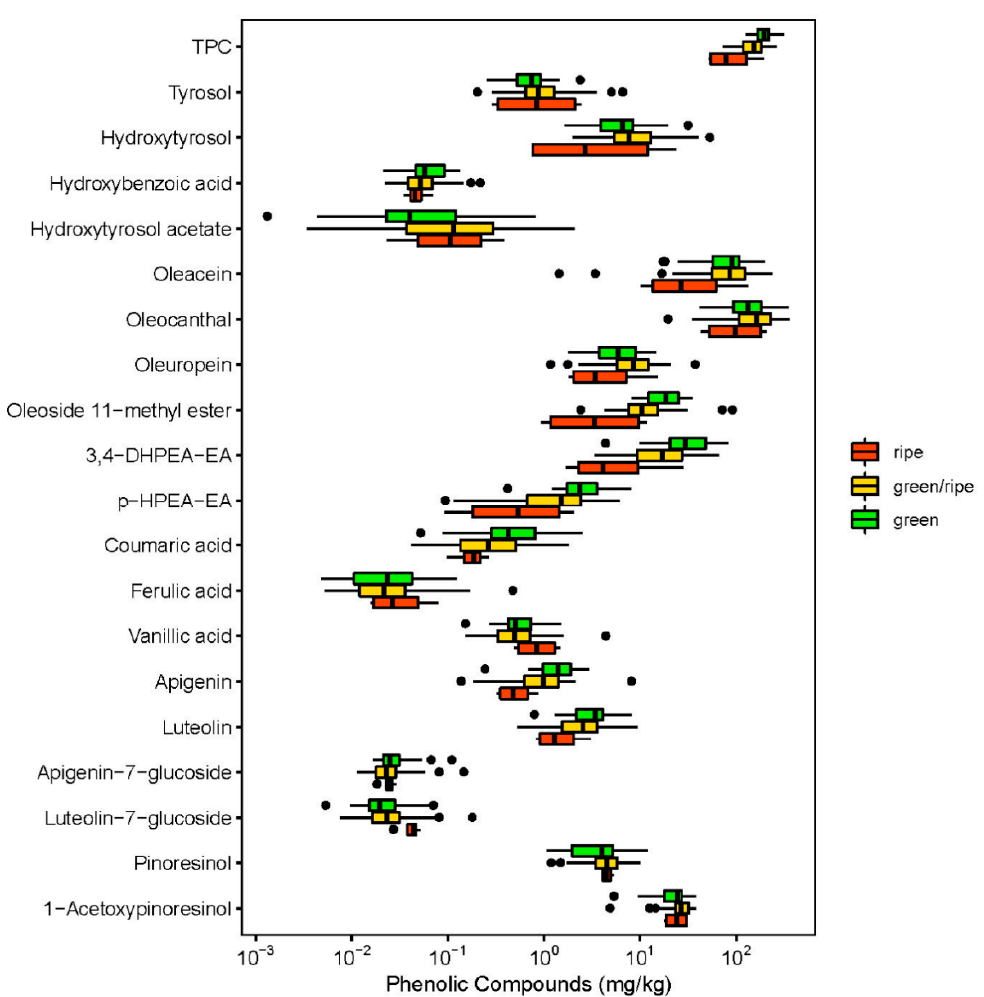
Figure 2. Distribution of individual phenolic compounds between the three different measured ripening flavors ripe, green/ripe and green.